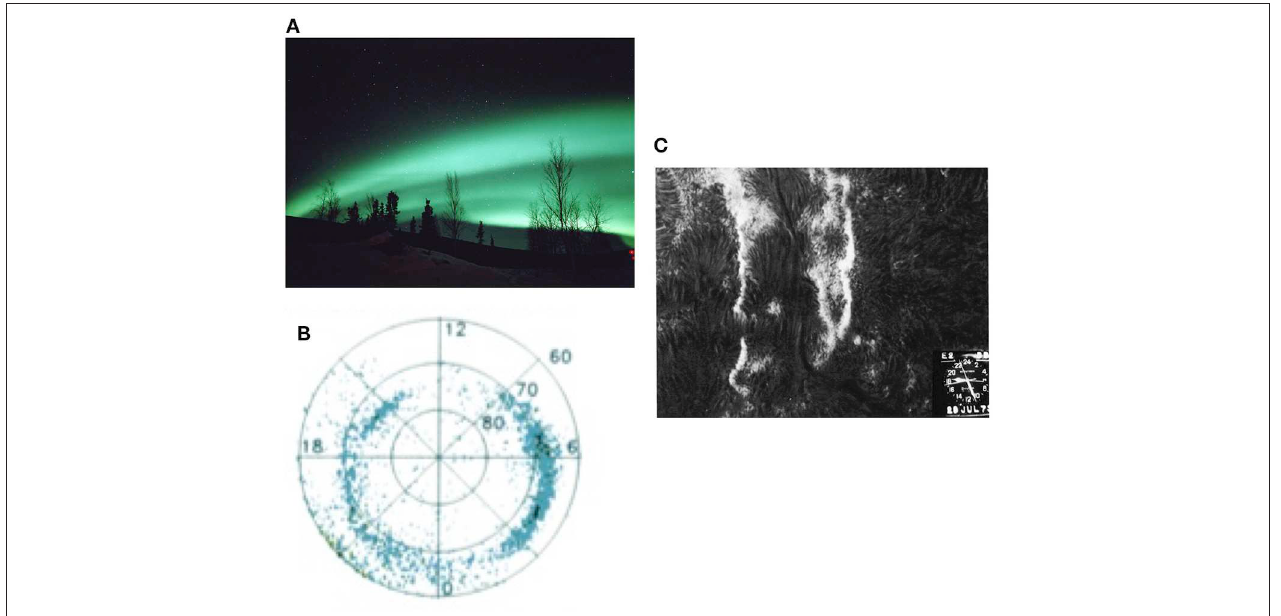
FIGURE 4 | (A) Quiet auroral arcs (often multiple) produced directly by the dynamo (Permission from the archives of the Geophysical Institute, University of Alaska Fairbanks). (B) The distribution of quiet arcs (viewed from a satellite) along the auroral oval (Courtesy of G. Parks). (C) An example of spotless flares (adopted from Figure 20a in Svestka (2004); permission from Springer Nature). Note the dark filament between two